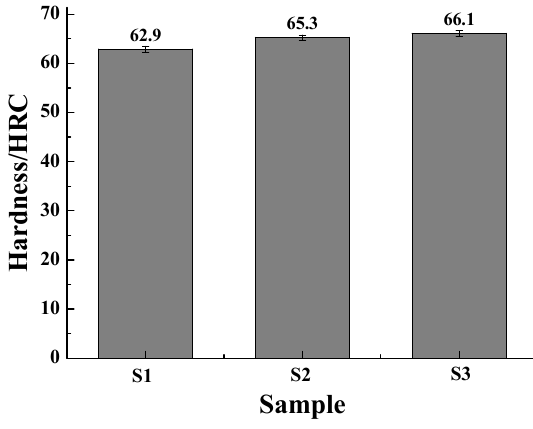
Figure 4. Hardness of the laser cladded Fe ‐ based coatings.